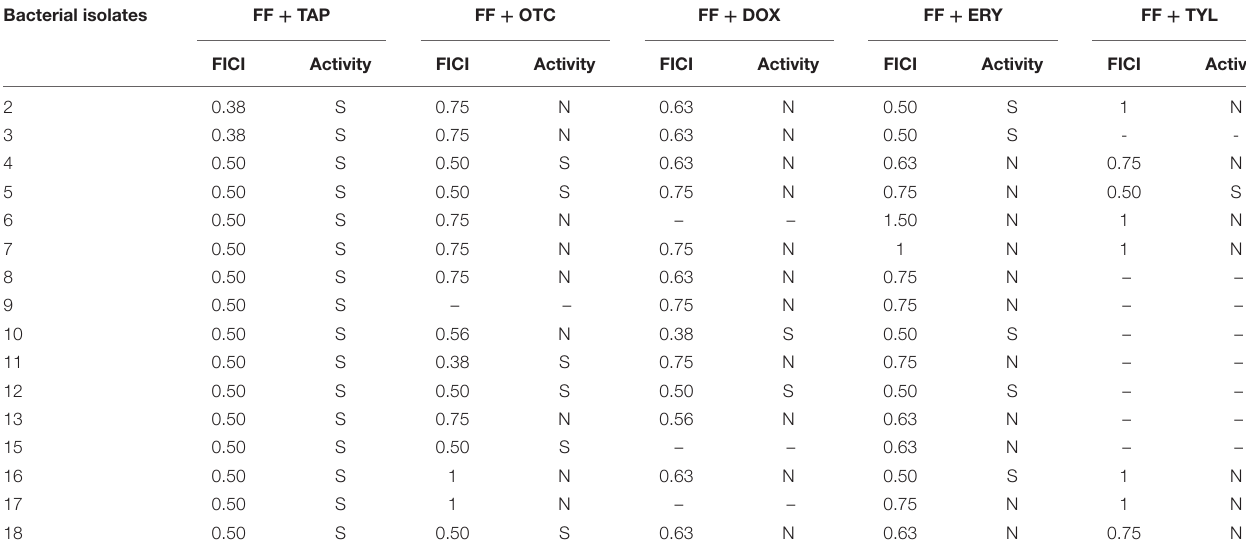
TABLE 4 | In vitro inhibitory activity of FF with other antibiotic combinations against P. multocida by checkerboard assay. Bacterial isolates FF + TAP FF +